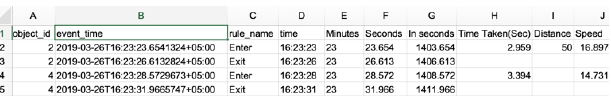
Figure 5. Camlytics setup for Traffic analysis on a 50 m road section.